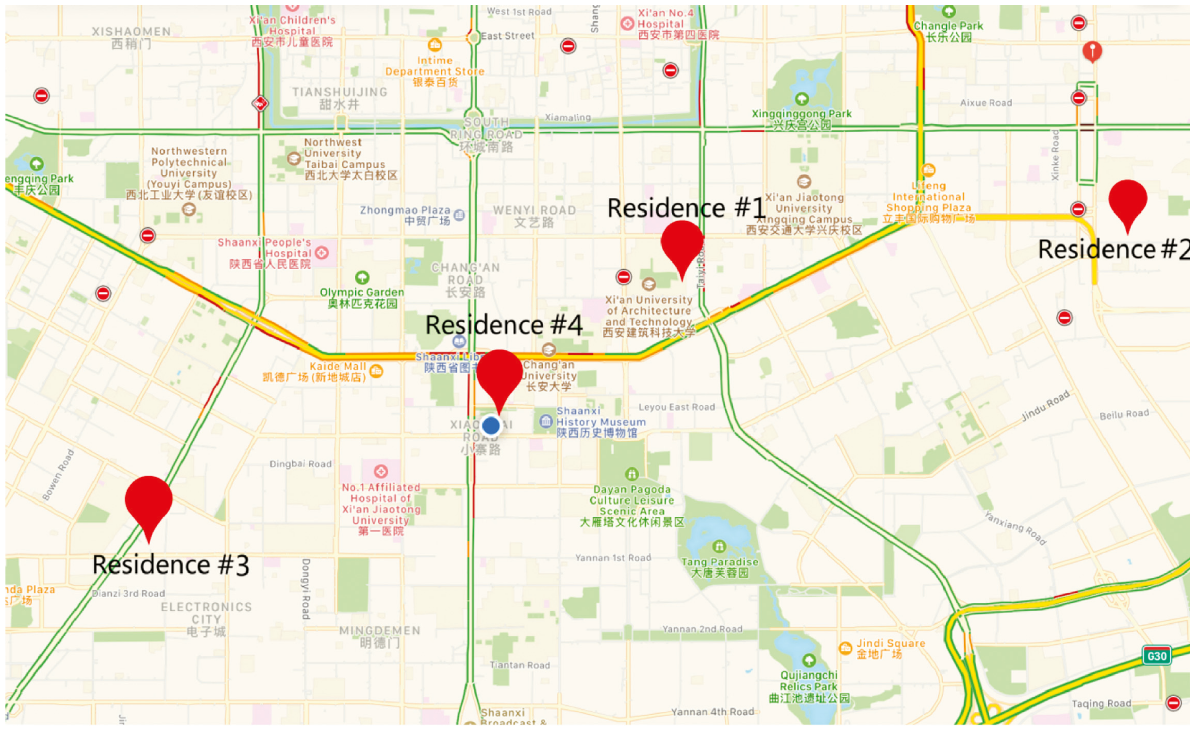
Figure 1: Locations of the four measured residences. Table 1: Detailed information on the four recruited